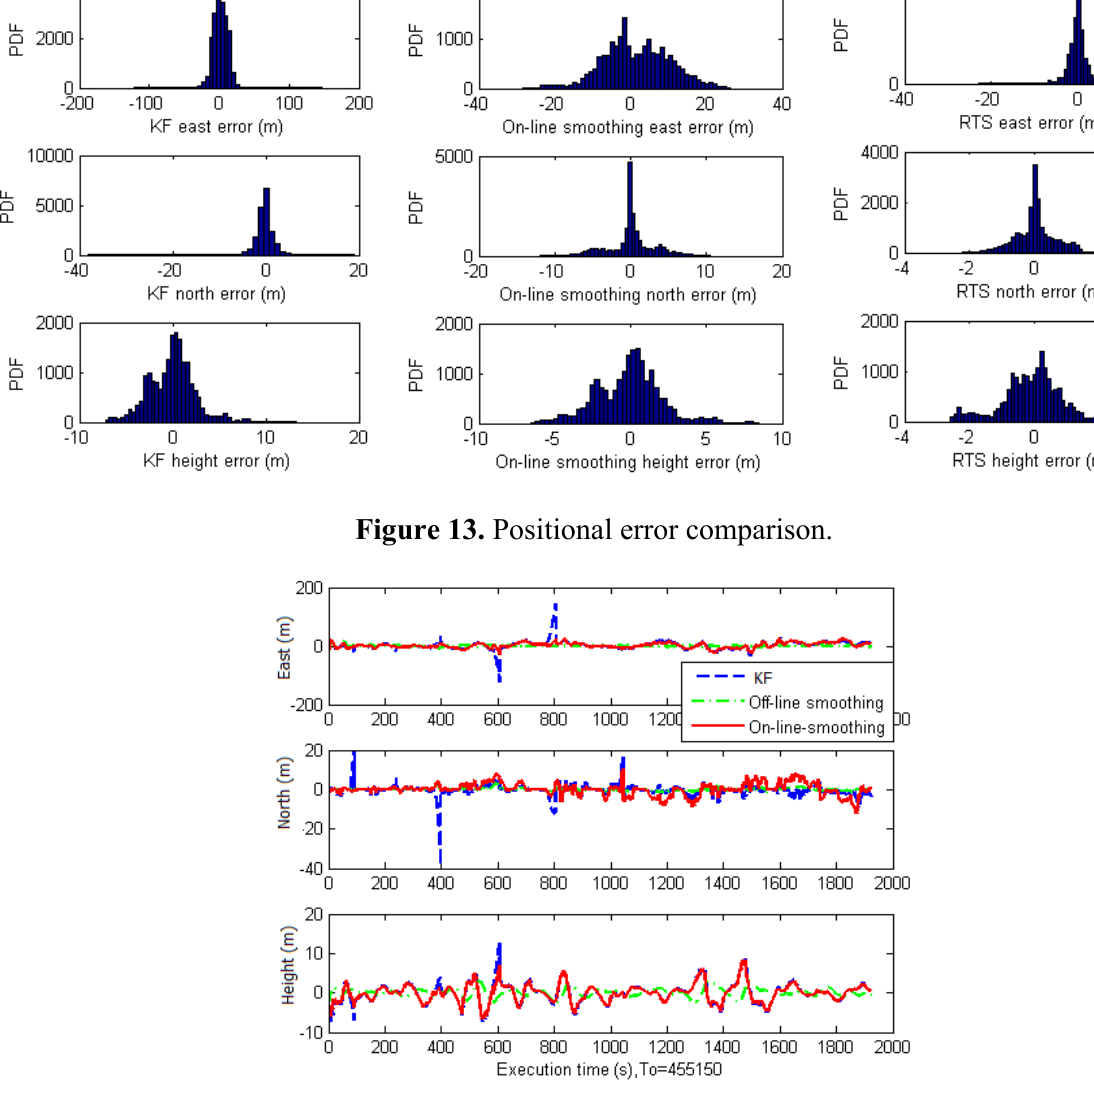
Table 4. Comparison of three estimation strategies in terms of orientation error.